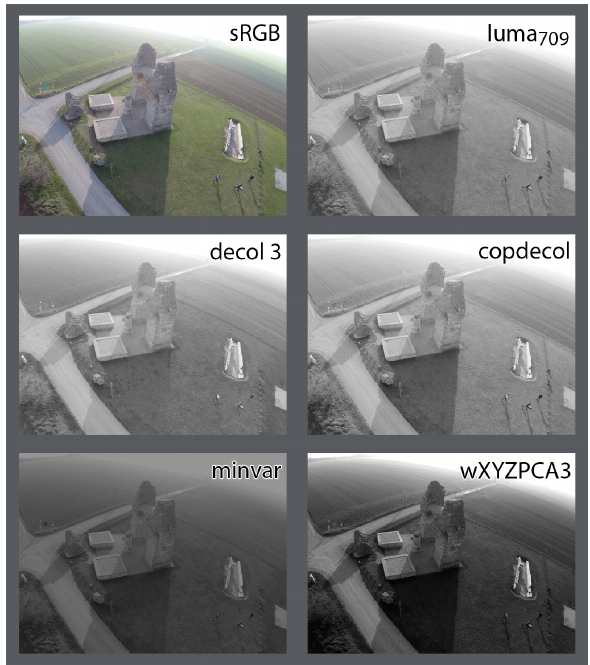
Figure 1. A visualisation of five decolourization